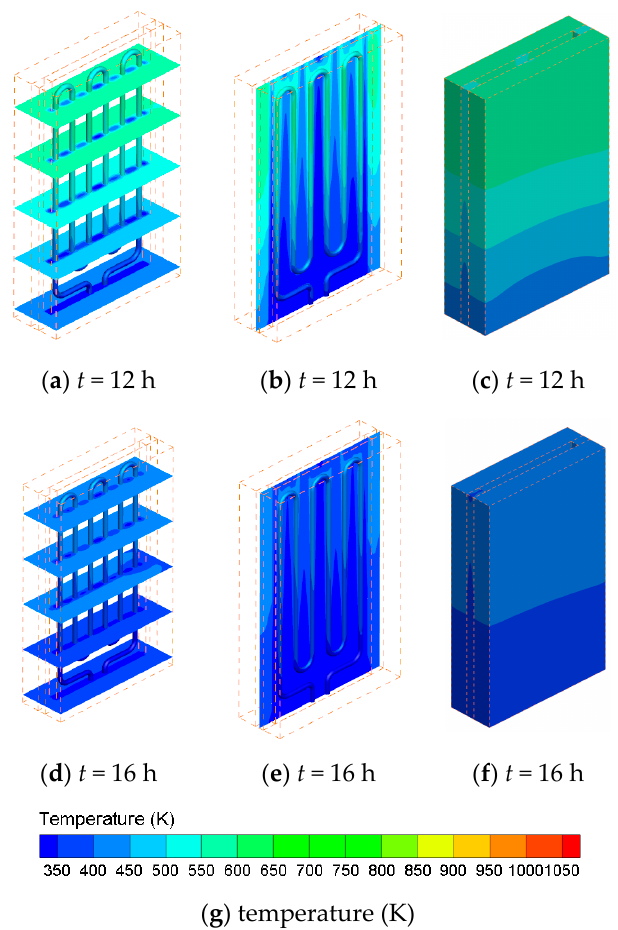
Figure 7. The temperature contours of the cross-sections of the bricks at different heights ( a , d ), the middle cross-section of the flow channel ( b , e ), the surface of the heating element ( a , b , d , e ), the outer surfaces of the bricks ( c , f ) at different discharging time ( t = 12 h and 16 h), and the temperature scale ( g ).